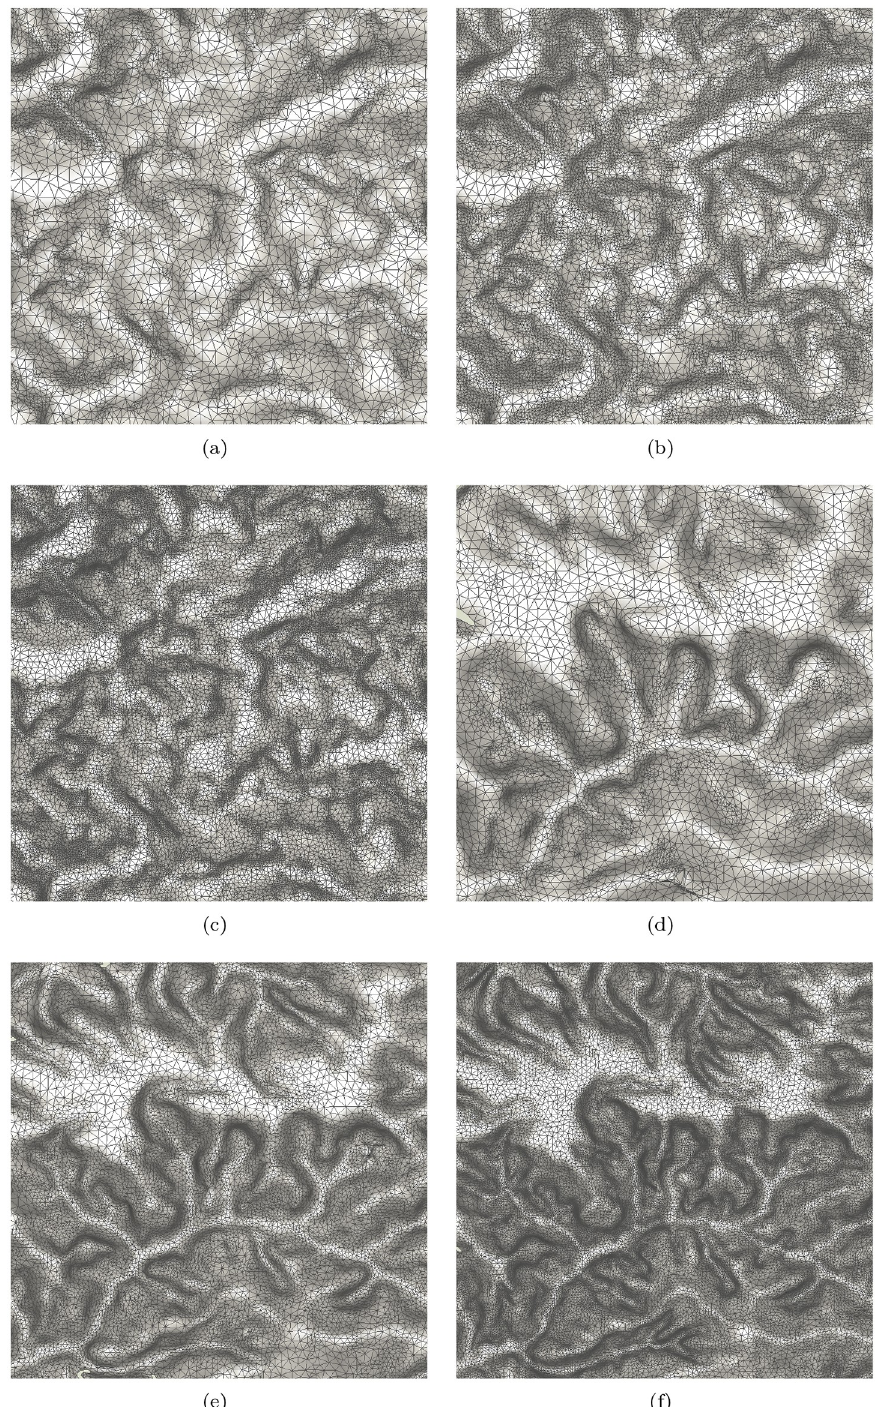
Fig 6. The sampling results of two data through MPS on basis of the eigenvalues from SVD. The adaptive sampling rates are (a): 2%, (b): 5% and (c): 10%, respectively. (d), (e) and (f) are the corresponding results of another data.